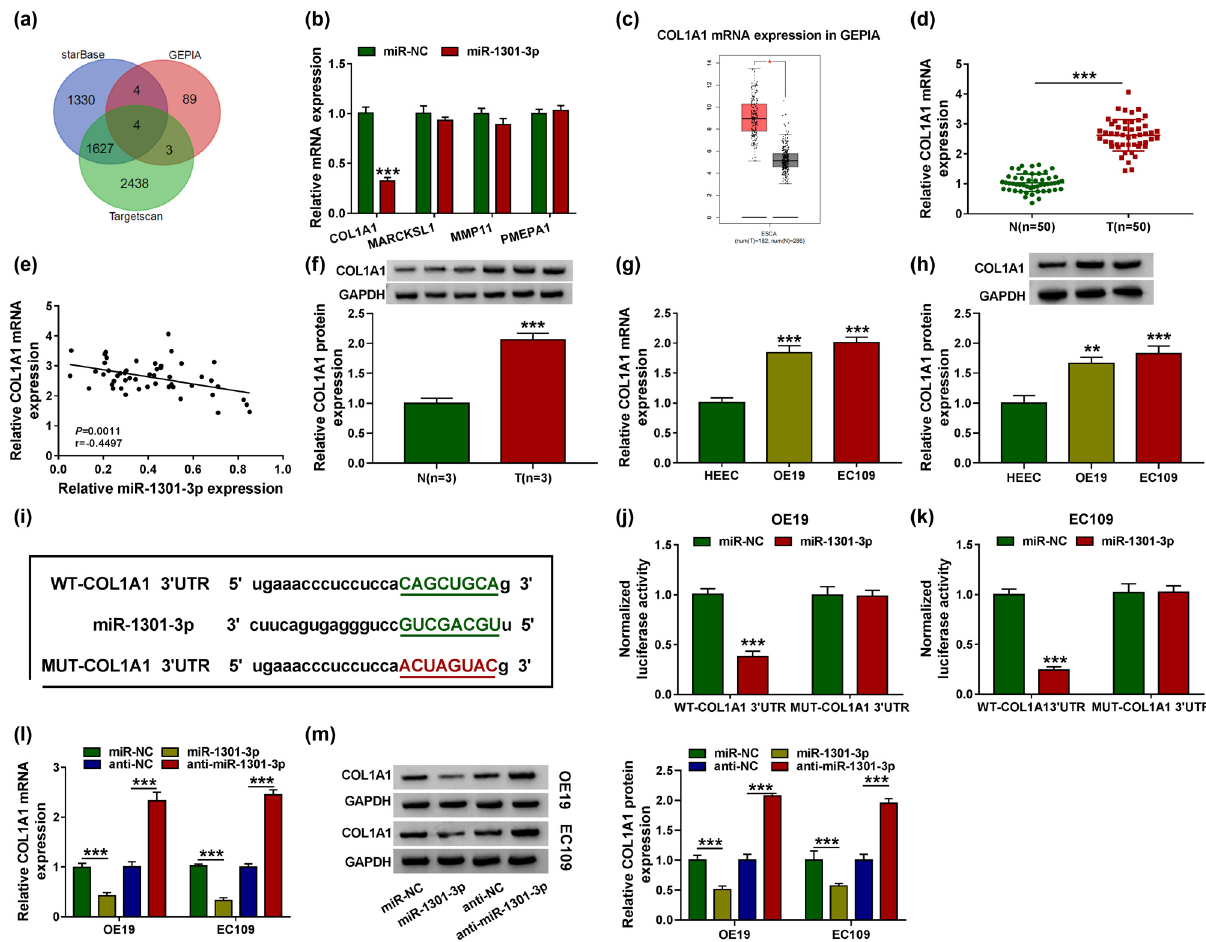
Figure 5: The targeted relationship between miR - 1301 - 3p and COL1A1. ( a ) Starbase, targetscan, and GEPIA databases were used to predict genes. ( b ) The mRNA expression level of COL1A1, MARCKSL1, MMP11, and PMEPA1 was detected by RT - qPCR through overexpression of mir - 1301 - 3p. ( c ) COL1A1 mRNA expression was predicted by GEPIA database. ( d ) The expression level of COL1A1 was detected by RT - qPCR in EC tissues and adjacent normal tissues. ( e ) The correlation level between miR - 1301 - 3p and COL1A1 was measured. ( f ) The COL1A1 expression was detected by western blot analysis. ( g and h ) The mRNA and protein expression of COL1A1 in EC cells were tested by RT - qPCR and western blot analysis. ( i ) The binding site of miR - 1301 - 3p and COL1A1 was measured by starBase v2.0. ( j and k ) The interaction between miR - 1301 - 3p and COL1A1 in OE19 and EC109 cells was determined by dual - luciferase reporter assay. ( l and m ) The COL1A1 mRNA and protein expression were detected by RT - qPCR and western blot analysis after transfecting with miR - NC, miR - 1301 - 3p, anti - NC, and anti - miR - 1301 - 3p. ** P < 0.01, *** P <